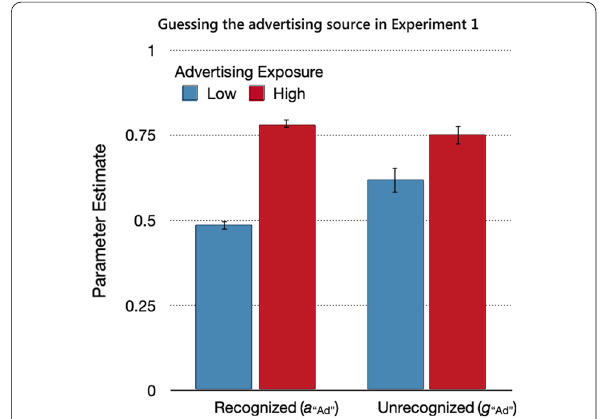
Fig. 4 Guessing the advertising source in Experiment 1. Note : Parameter estimates of the parameters reflecting the probabilities of guessing the advertising source for recognized ( a “Ad” ) and unrecognized ( g “Ad” ) statements as a function of advertising exposure (low, high). The error bars represent standard errors